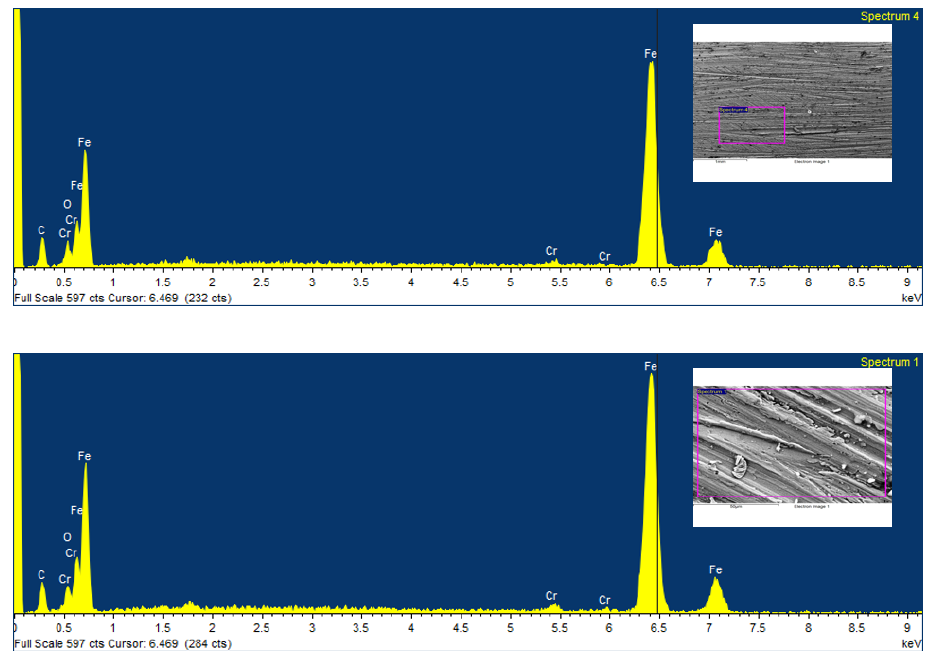
Figure 11. EDS Analysis of untreated pins.